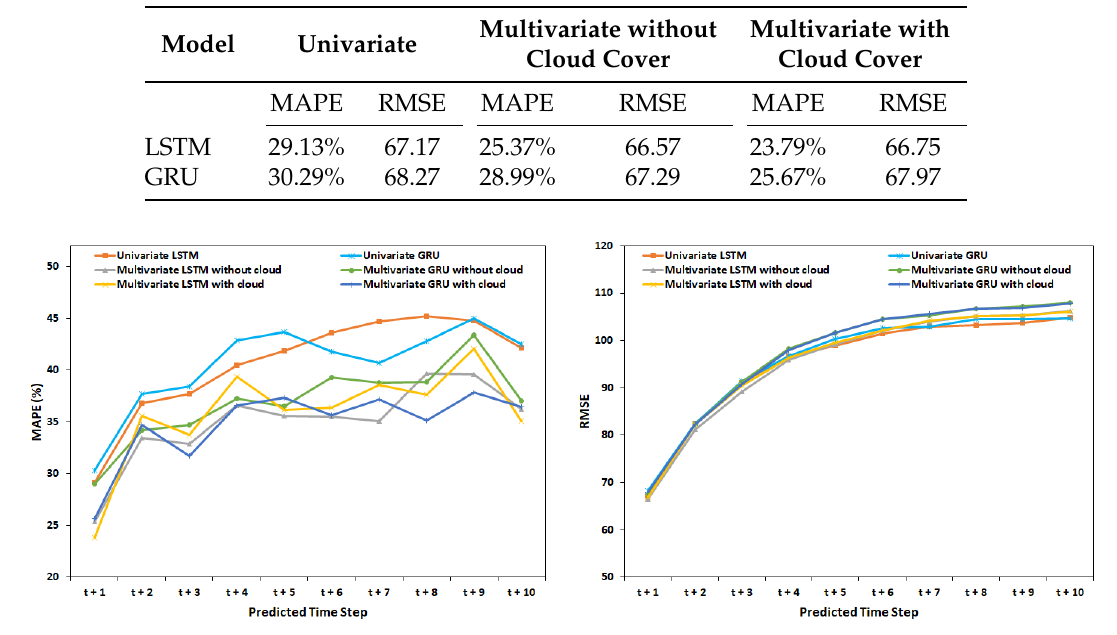
Table 1. Comparison of forecast errors at one time step across one year of hourly testing data.